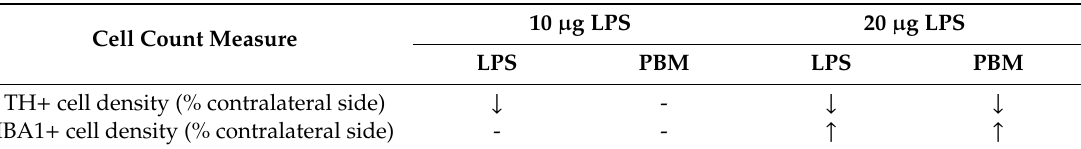
Table 3. A summary of the main immunohistochemical cell counting results from the 10 µ g and 20 µ g LPS experiments. Arrows represent a significant di ff erence compared to vehicle rats in the specified direction; hyphens represent no significant di ff erence from vehicle rats. Cell Count Measure